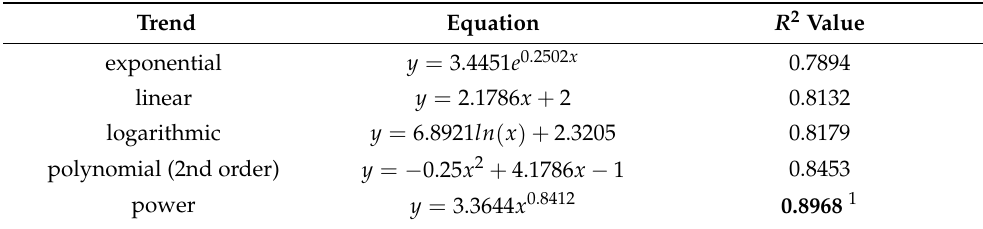
Table 5. Equations of trendlines for the Scopus dataset corresponding to the expression “temporal big data” (for the years 2014–2020).